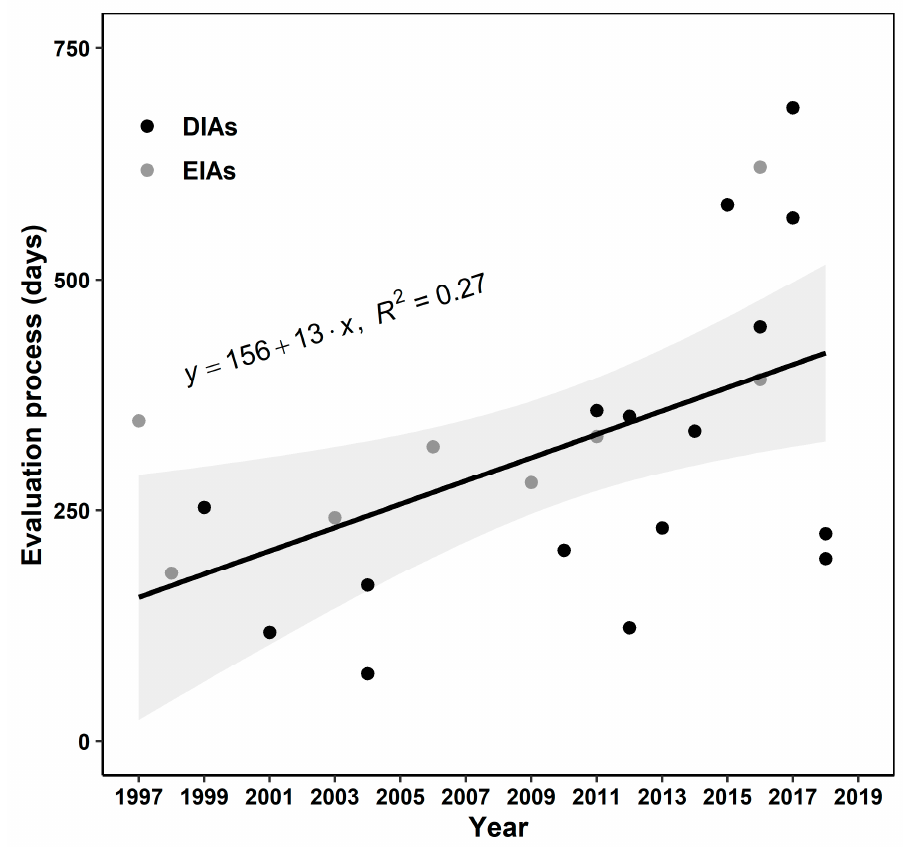
Figure 5. Linear regression between the period of the evaluation process (days) of projects and the publishing year in the SEIA.